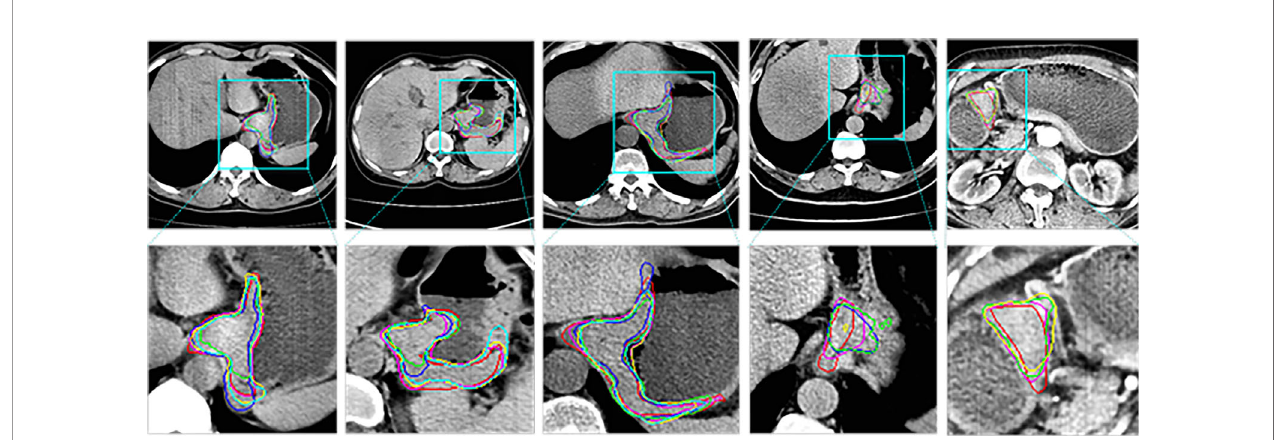
FIGURE 4 | 2D visual comparisons of segmented slices from 3D CT volumes. Up row, CT slicers with red boxes to indicate the tumor areas; Down row, ground truth (red) delineated by experienced radiologists and corresponding segmented tumor contours using 3D U-Net (10) (blue), nnU-Net (32) (green), DAF3D (14) (cyan), 3D FPN (12) (yellow) and our method (purple).